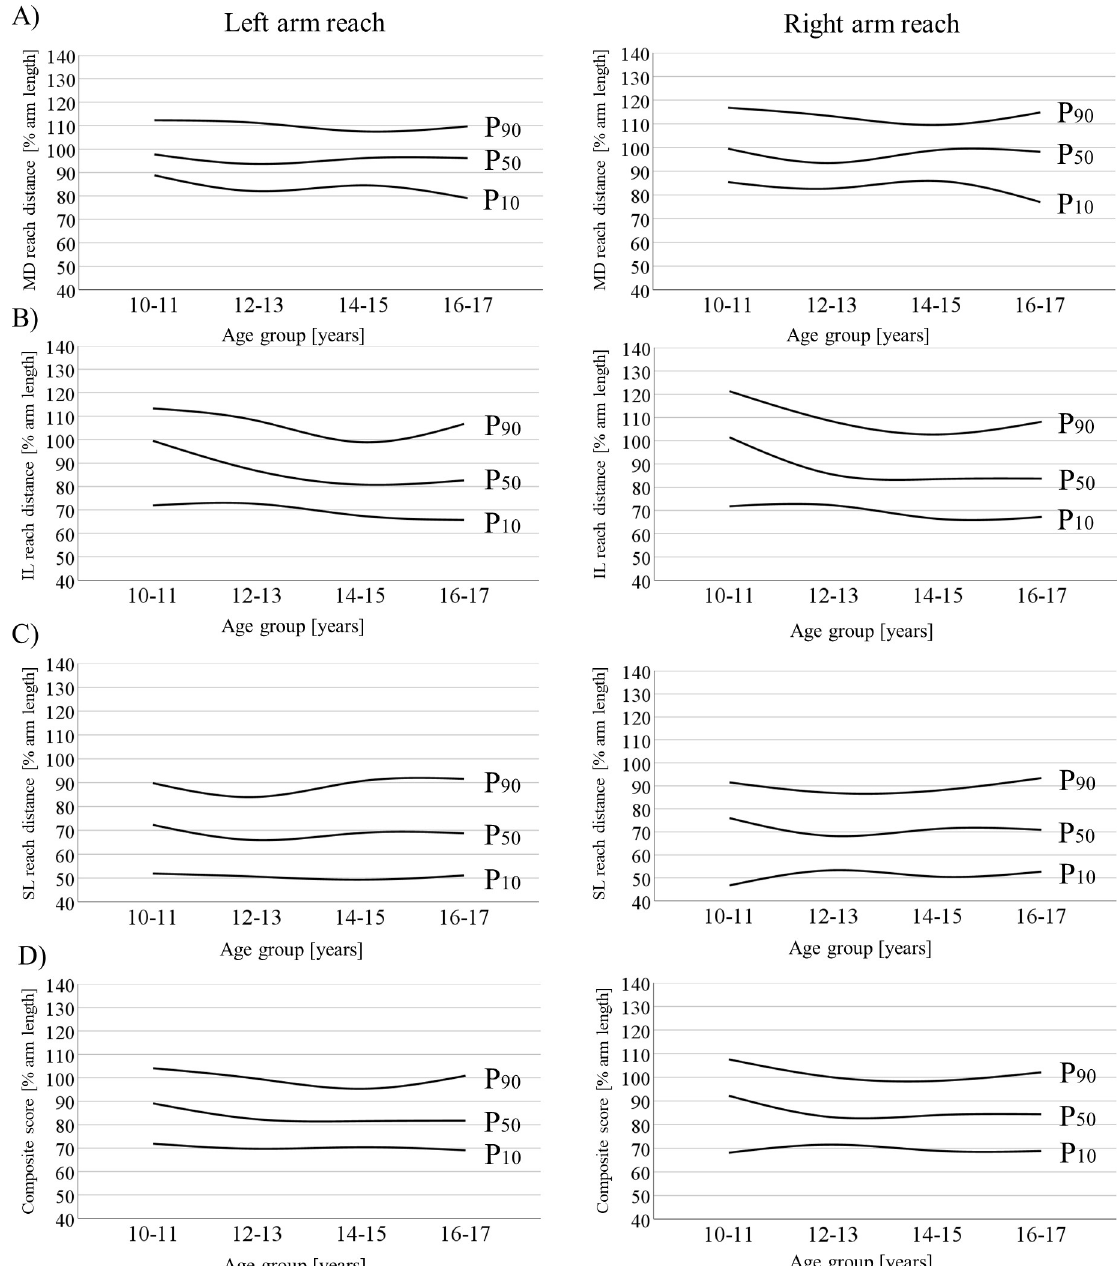
Fig 3. Smoothed curves for the 10 th , 50 th , and 90 th percentiles (% arm length) of the (A) medial, (B) inferolateral, and (C) superolateral reach directions as well as the (D) composite score during left and right arm reach in females aged 10 to 17 years. IL = inferolateral; MD = medial; SL =